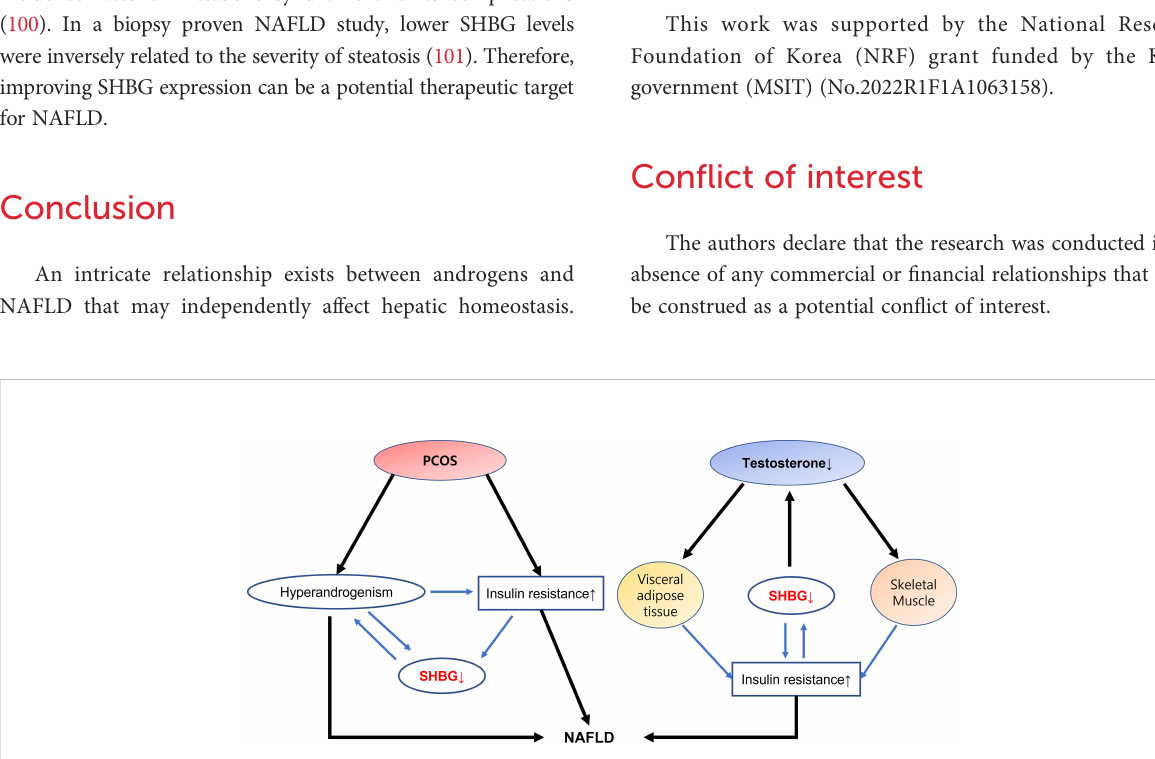
FIGURE 1 Interactions of SHBG with androgen dysfunction on NAFLD development In PCOS, HA and insulin resistance leads to downregulate SHBG production, and develops NAFLD. On the contrary, interaction of low testosterone with visceral adipose tissue and skeletal muscle may modulate insulin resistance that decreases SHBG expression and increase the risk of NAFLD. SHBG has a dual action in interacting insulin resistance as well as in acting as a buffer in the context of androgen homeostasis suggesting a role as a surrogate marker in the development of NAFLD. SHBG, sex hormone binding globulin; NAFLD, nonalcoholic fatty liver disease; PCOS, polycystic ovary syndrome; HA,